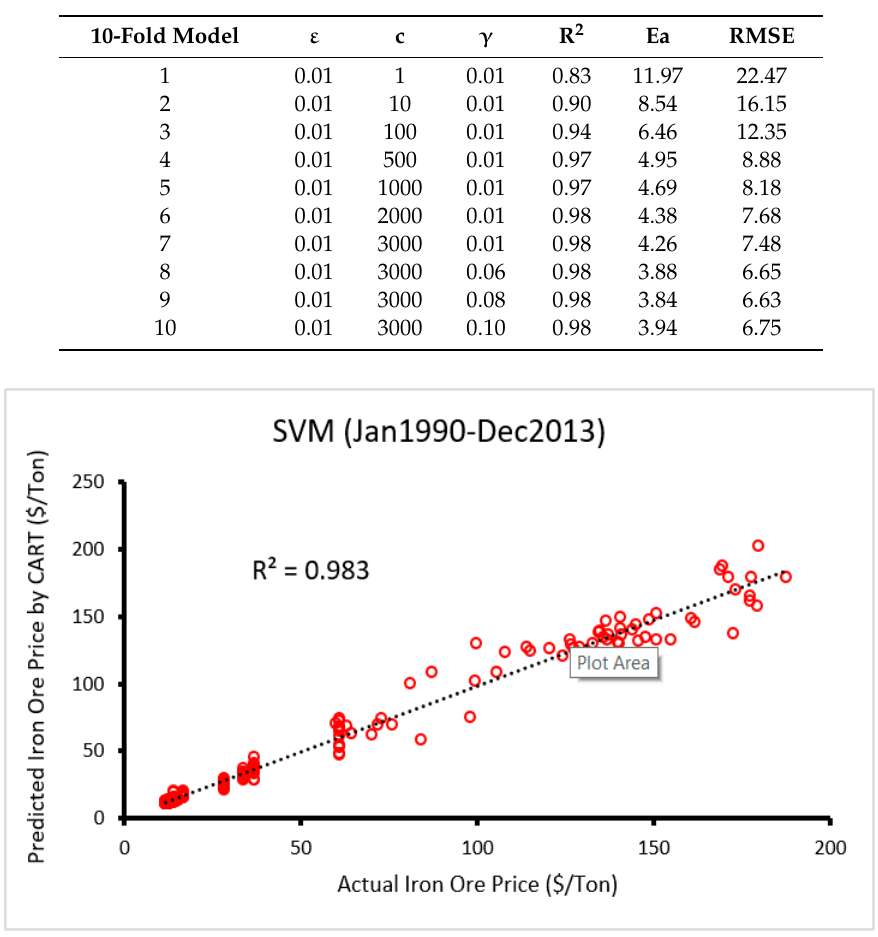
Table 3. Results of ten-fold cross-validation and optimal values of C, ε , and γ in predicting iron ore price.